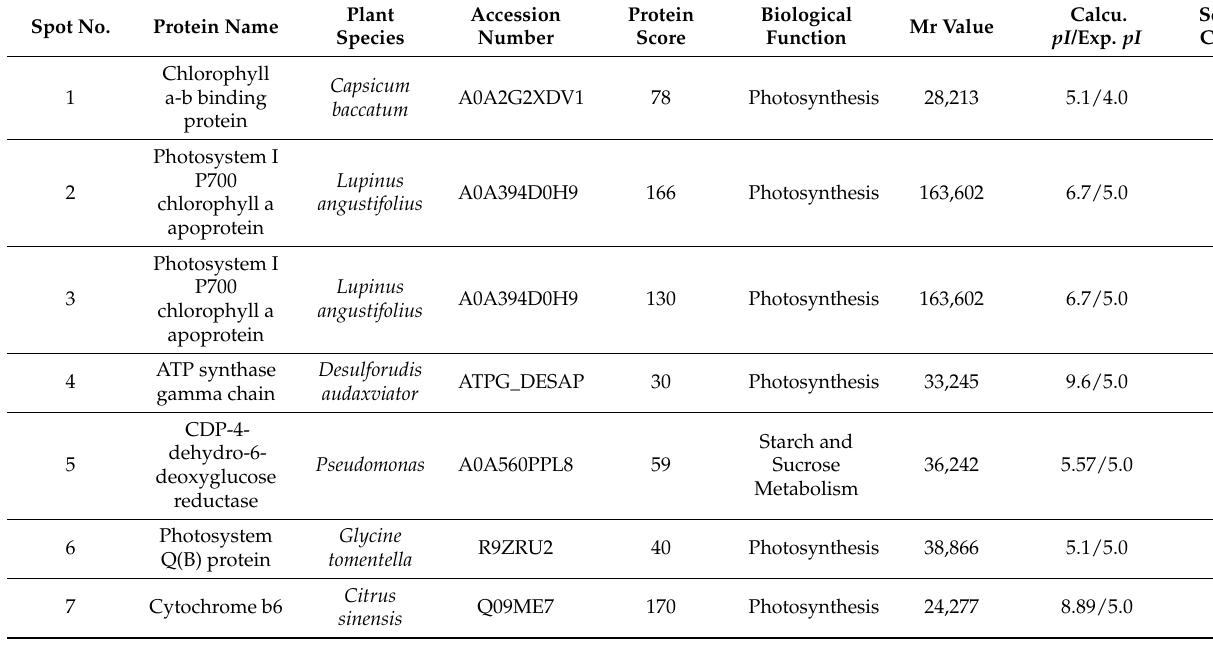
Table 1. Proteins identified in 2D-BN-SDS-PAGE map of okra thylakoids.